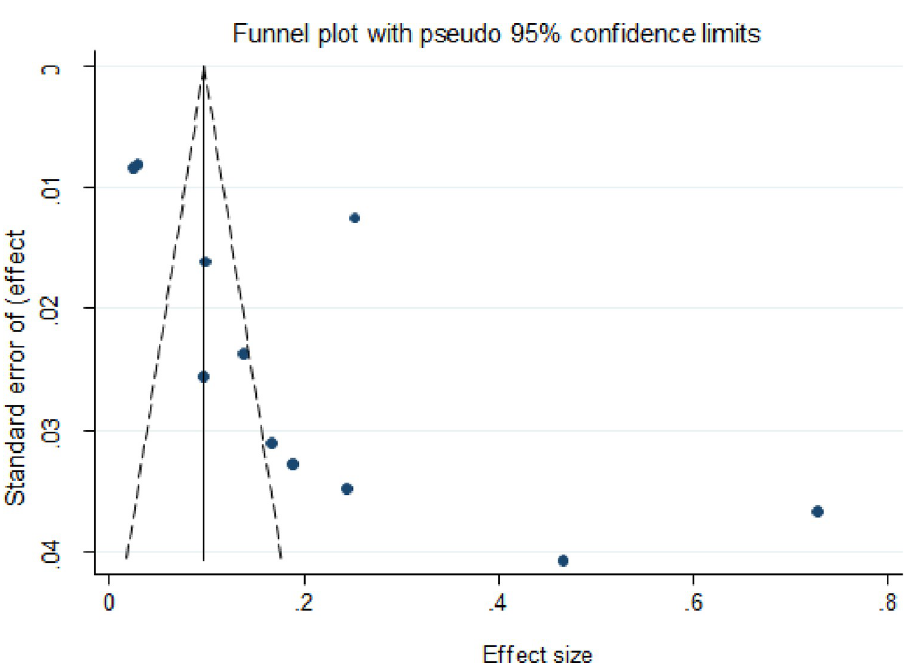
Fig 8. Funnel plot of a subgroup of 11 of the 20 selected studies for smear-positive EPTB.